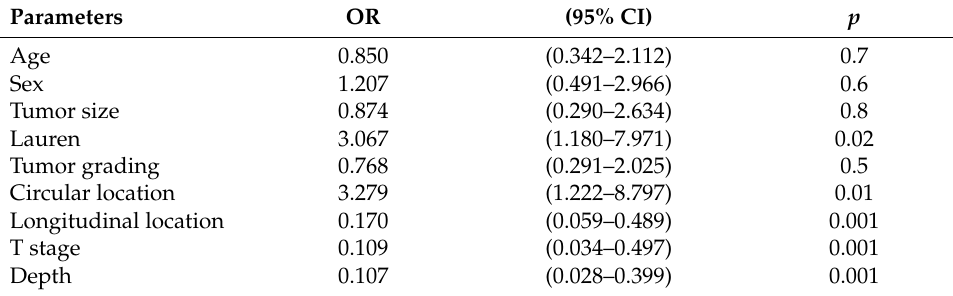
Table 7. Multivariate